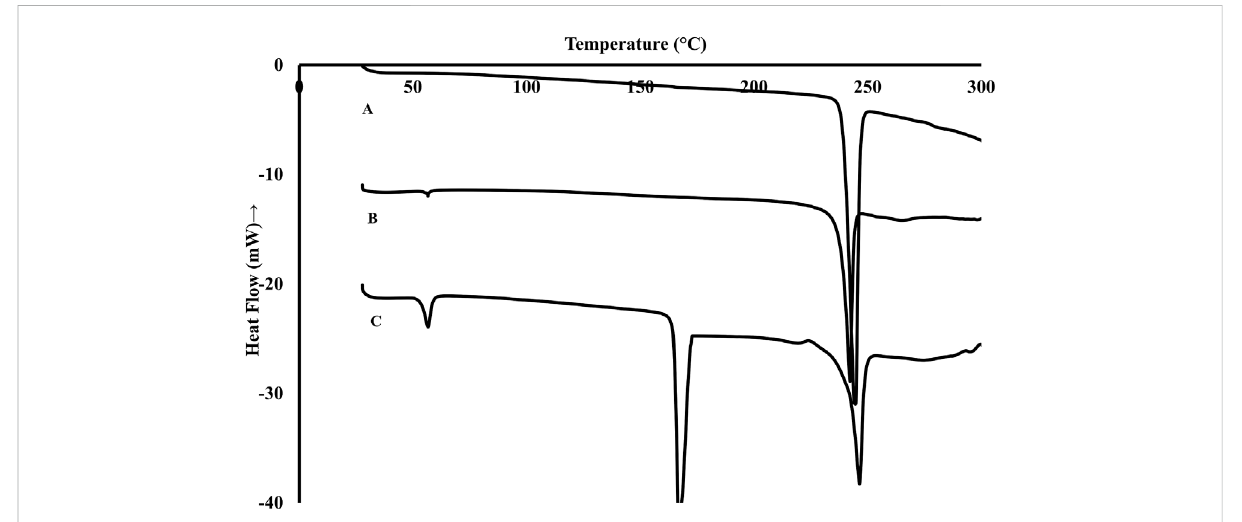
FIGURE 2 DSCthermogramsofpureRu fi (A) ,physicalmixtureofRu fi withallexcipientsusedinpreparationofRu fi -NCs (B) andFreezedriedRu fi -NCs (C) .